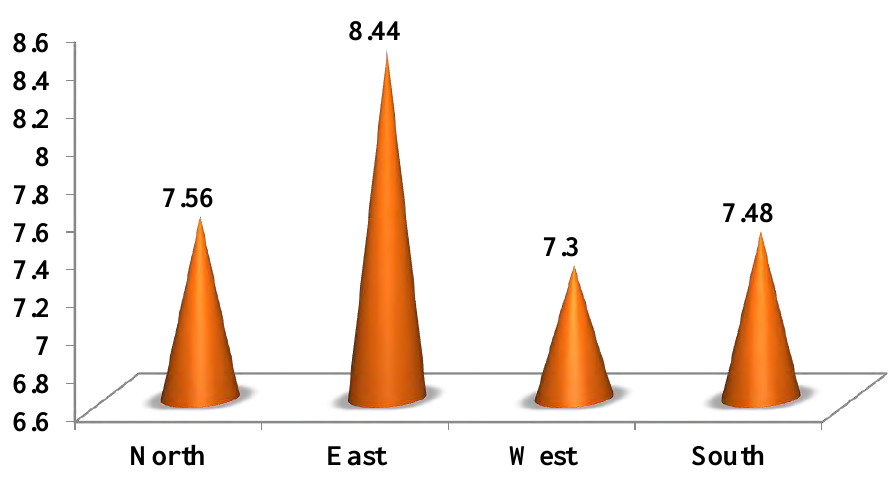
Figure 2. Graphical representation of mean scores with regard to North, East, West and South regions female baseball players on the sub-parameter Self-Development